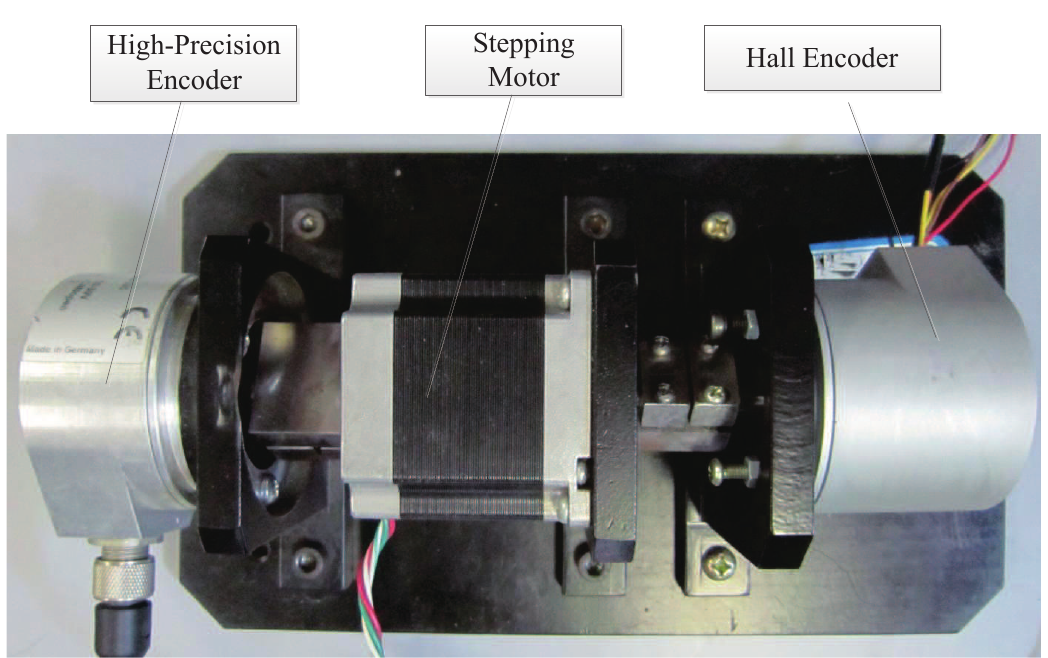
Figure 11. The diagnostic platform for the rotary